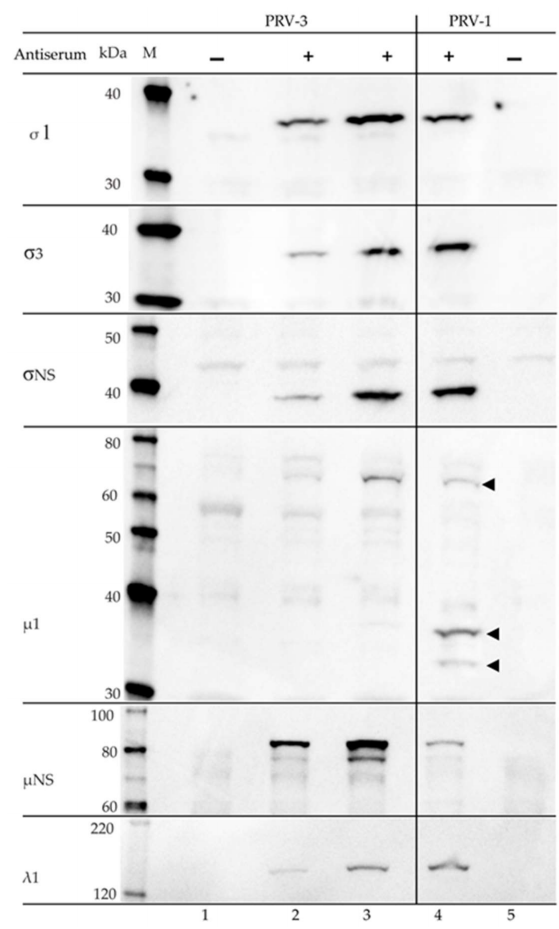
Figure 7. Western blots of PRV-3 and PRV-1 blood pellets using polyclonal antisera developed against recombinant proteins of PRV-1 σ 1, σ 3, σ NS, µ 1, µ NS, and λ 1. Lane 1-3 Rainbow trout: L1 negative control, L2-L3 PRV-3 infected samples. Lane 4-5 Atlantic salmon: L4 PRV-1 infected, L5: negative control. Arrowheads denote differing µ 1 fragments in PRV-1.